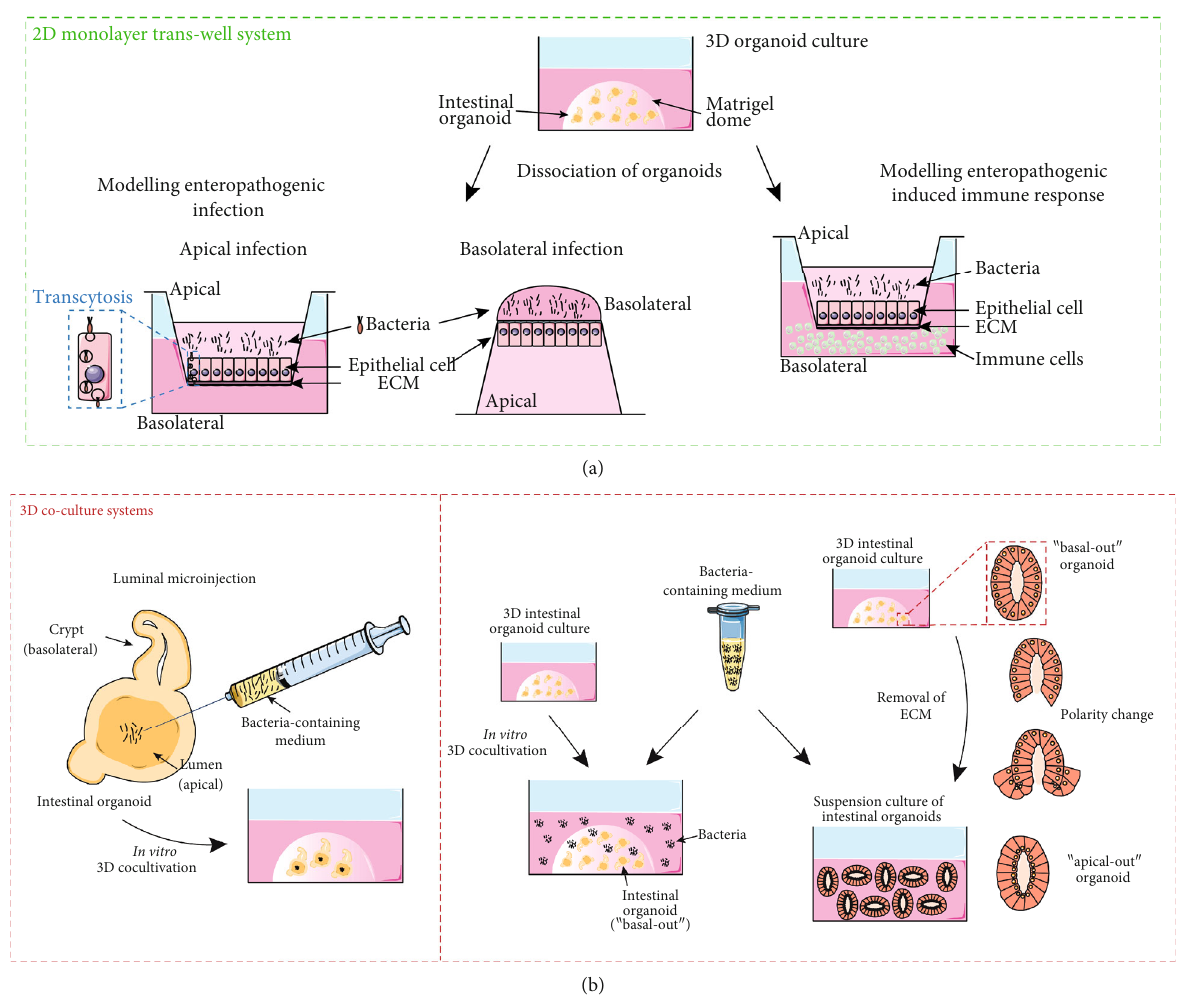
Figure 2: In vitro modeling of enteropathogenic infection. (a) 2D intestinal coculture models: bacteria are seeded onto the apical or basolateral surface of the intestinal epithelial monolayer (adapted from: Ranganathan et al., 2019 [38], Koestler et al., 2019 [39]). Optionally, immune cells are added to the basolateral compartment of infected intestinal epithelium (adapted from: Noel et al., 2017 [31], Karve et al., 2017 [49]). (b) 3D intestinal coculture models: bacteria are either introduced into intestinal organoids via luminal microinjection (adapted from: Karve et al., 2017 [49]) or added to the culture medium of “ basal-out ” or “ apical-out ” intestinal organoids (adapted from: Co et al., 2019